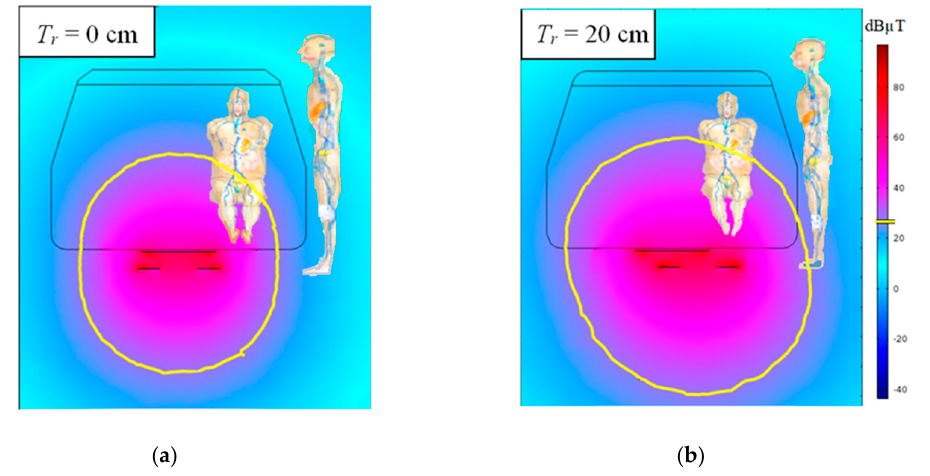
Figure 4. Magnetic flux density distribution for the aligned ( a ) and misaligned ( b ) coil positions in the case of CF composite chassis. The yellow line represents the ICNIRP limit (RL = 27 µT = 28.63 dBµT).